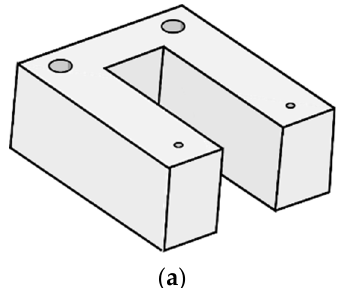
Figure 2. Schematic of the test rig configuration. (1) AC motor; (2) flexible coupling; (3–6) magnetic actuators; (4) test bearing housing; (5) bearing housing supporting structure; (7) test shaft; (8) supporting steel base.